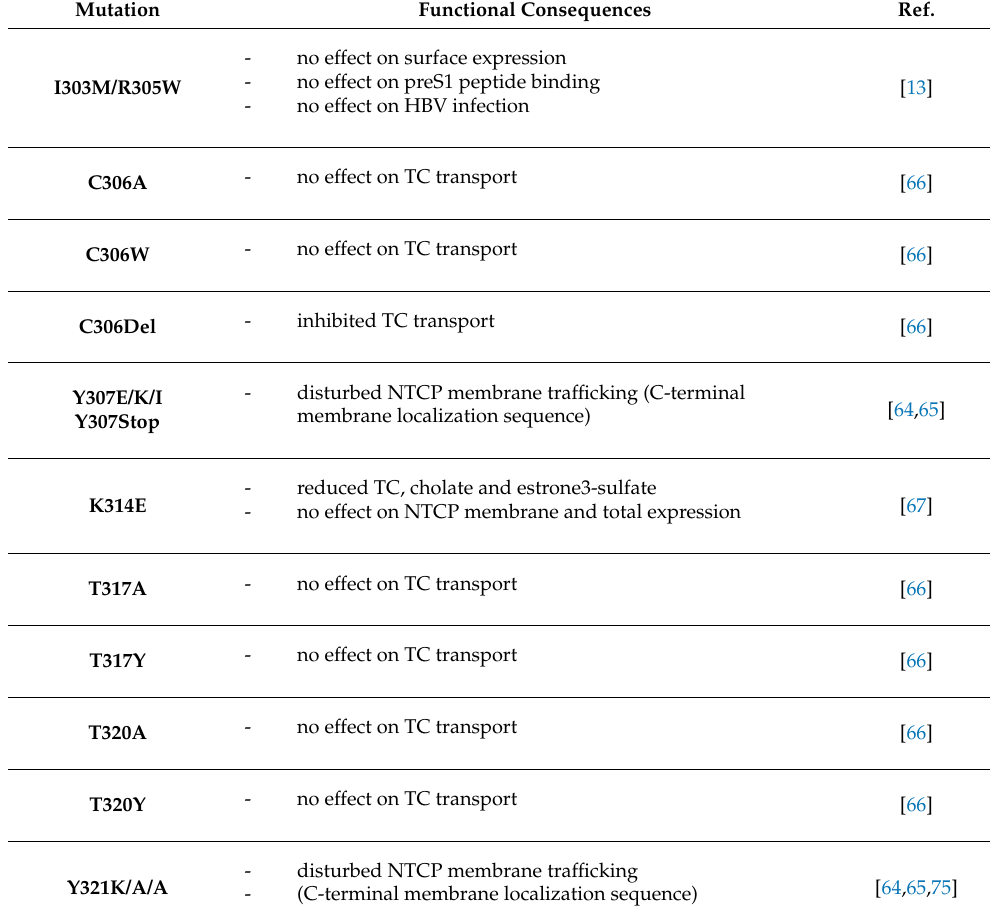
Table 1. Cont. Mutation Functional Consequences